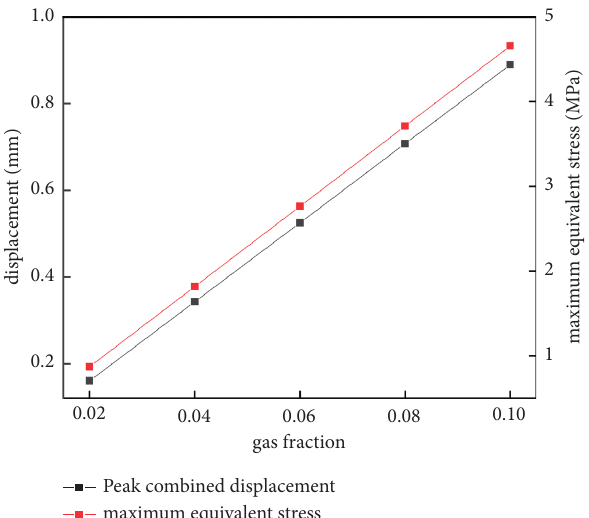
Figure 13: Variation curve of the peak combined displacement and maximum equivalent stress with natural gas fraction.